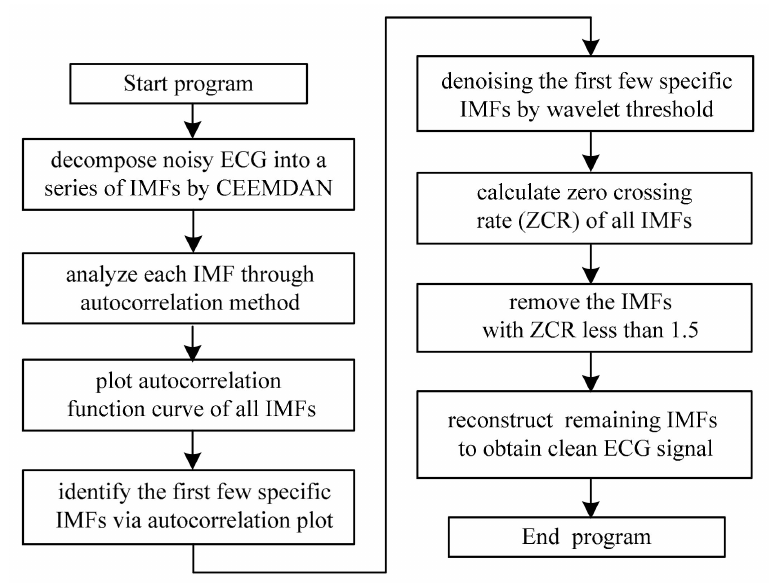
Figure 2. The flowchart of ECG signal